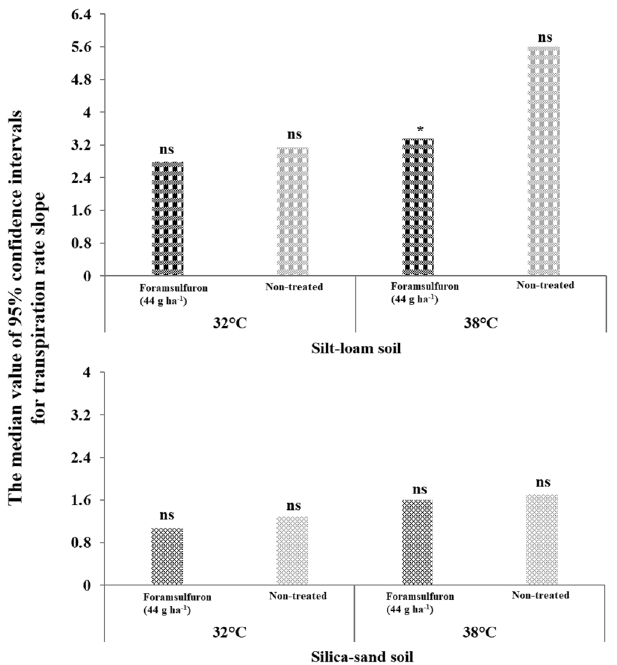
Figure 1. The median value of confidence intervals for transpiration rate slope among goosegrass [ Eleusine indica (L) Gaertn] plants grown in silt-loam and silica-sand treated with foramsulfuron (0 or 44 g ha −1 ) under high vapor pressure deficit (> 3.0 kPa) at varying air temperatures in a walk-in growth chamber located at the West Tennessee AgResearch and Education Center (Jackson, TN) during 2019. Data were collected 14 days after treatment. Signifigance levels for each median confidence interval value are presented in the graph below (ns = non-significant, * = significant at α = 0.05).